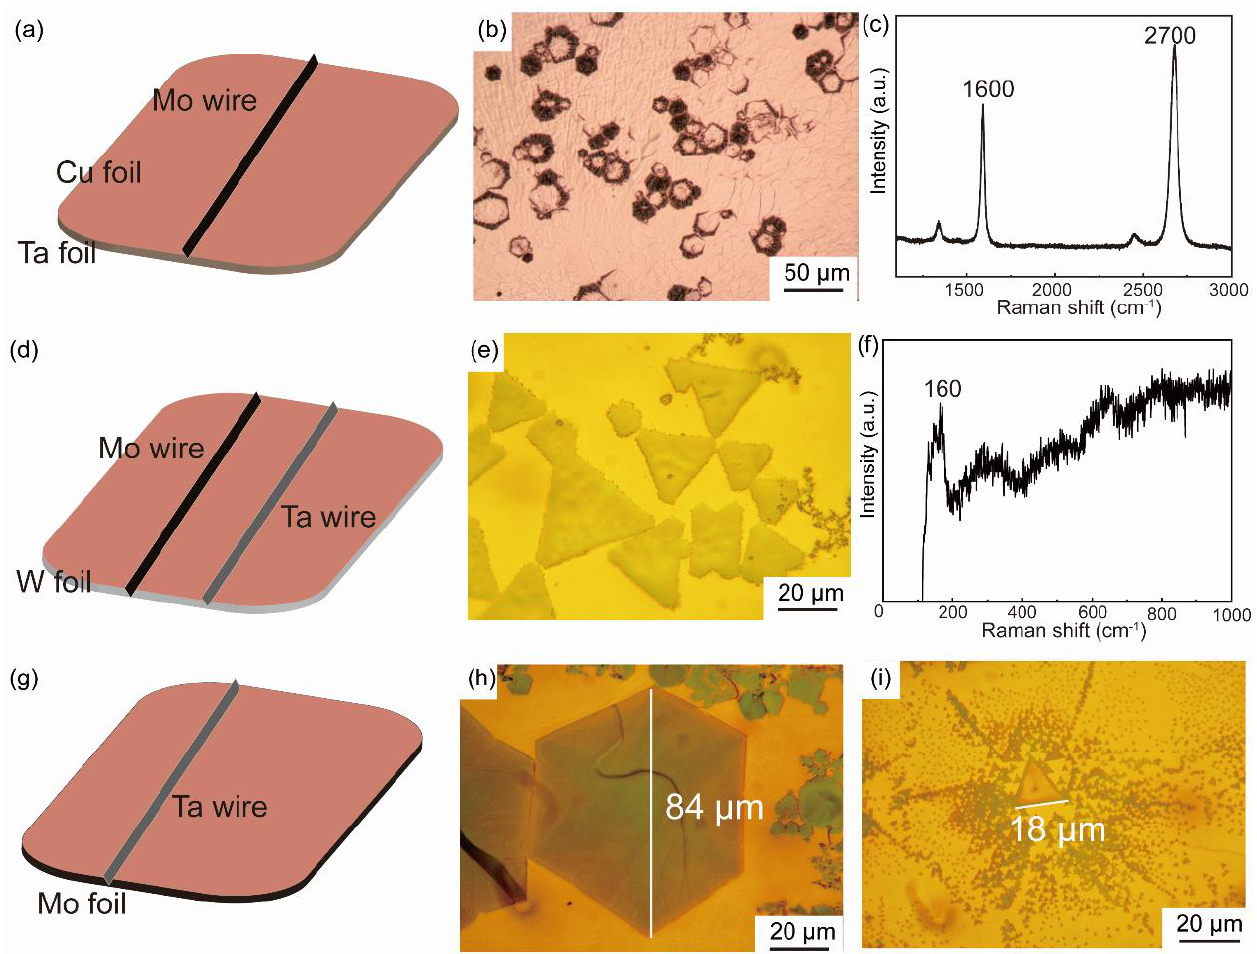
Figure 1. Several different stacking orders of transition metallic source: ( a ) Mo wire–Cu foil–Ta foil, ( b ) optical image and ( c ) Raman spectrum of graphene corresponding to ( a ). ( d ) Mo wire and Ta wire–Cu foil–W foil, ( e ) optical image and ( f ) Raman spectrum of TaC corresponding to ( d ). ( g ) Ta wire–Cu foil–Mo foil, ( h ) optical image of polygonal and ( i ) triangular nanosheet corresponding to ( g ).